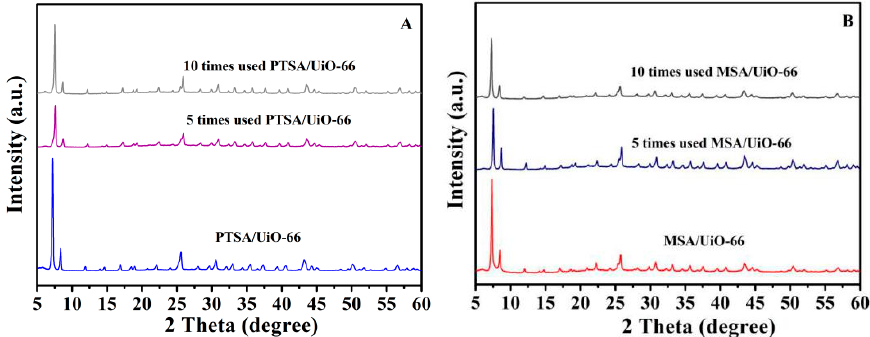
Figure 8. XRD patterns of the used PTSA/UiO-66( A ) and MSA/UiO-66( B ).